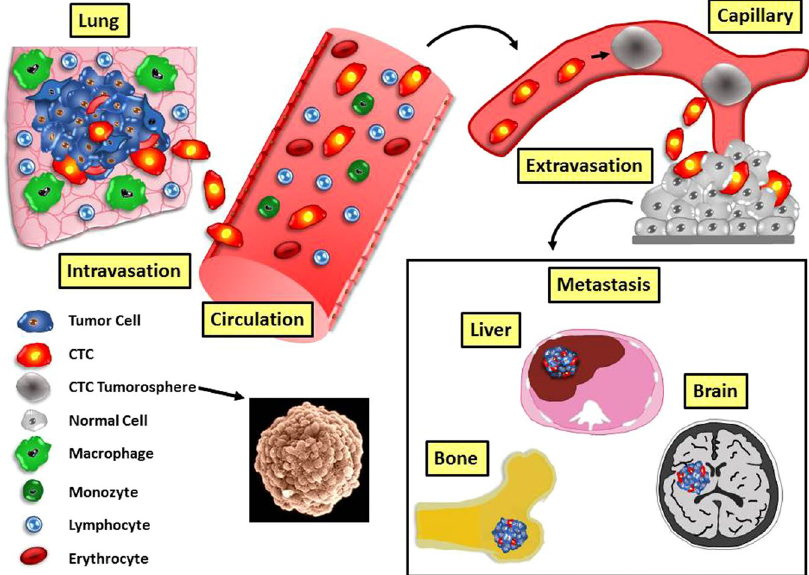
Figure 6. Scheme of the model of tumor dissemination including tumorospheres. SCLC originates in the lung and CTCs are shed from the tumor and intravasate into the circulation. CTCs or small clusters of CTCs may become trapped in small capillaries of distal sites and grow into large tumorospheres which are resistant to radiochemotherapy. Eventually tumor cells derived from tumorospheres or the whole spheroid extravasate and grow aggressively into secondary lesions preferentially in liver, bone and brain. Tumorospheres may still be present as part of the metastases and this model may likewise apply to related tumors, such as glioblastoma and neuroectodermal tumors which show a similar clinical course and dismal